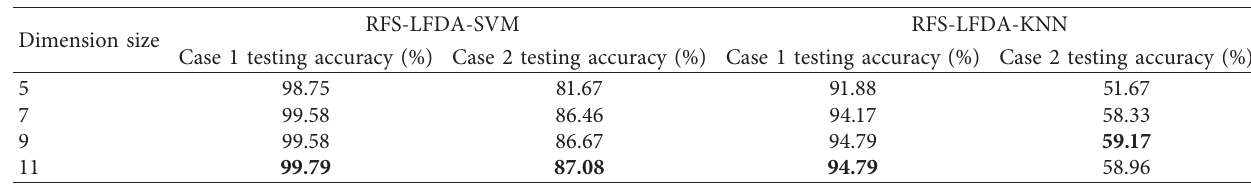
Table 7: Testing accuracies of RFS-TCA-SVM and RFS-TCA-KNN. RFS-TCA-SVM Dimension size